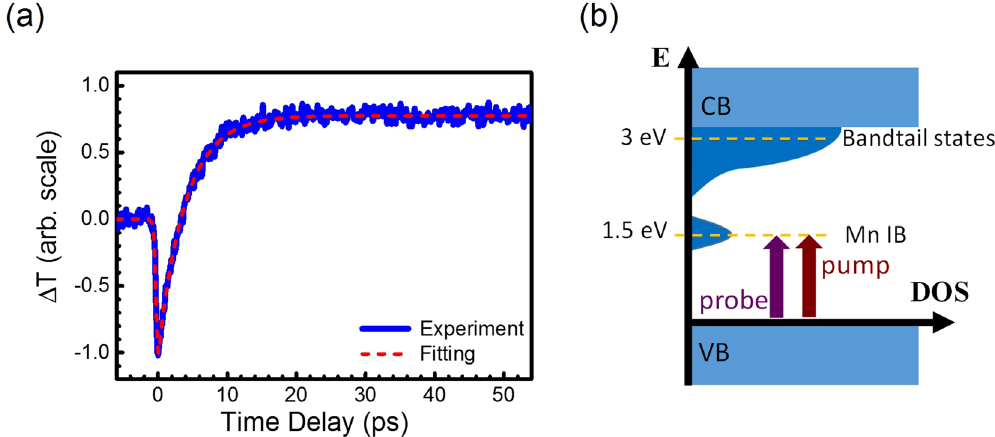
Figure 3. ( a ) The transient transmission changes of the probe pulses through the Mn-doped GaN with concentrations of 1.1 × 10 19 cm − 3 . The pump/probe wavelength (photon energy) is 820 nm (1.5 eV). ( b ) The schematic diagram illustrates the density of states in Mn-doped GaN. The slow response in ( a ) is associated with carrier dynamics in the Mn IB states monitored by the 1.5 eV probe